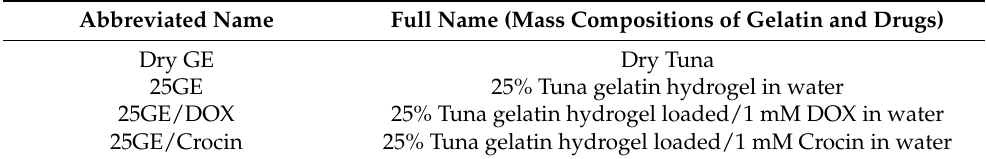
Table 1. Correspondence between the abbreviated code and full naming code (description of gelatins) under study.